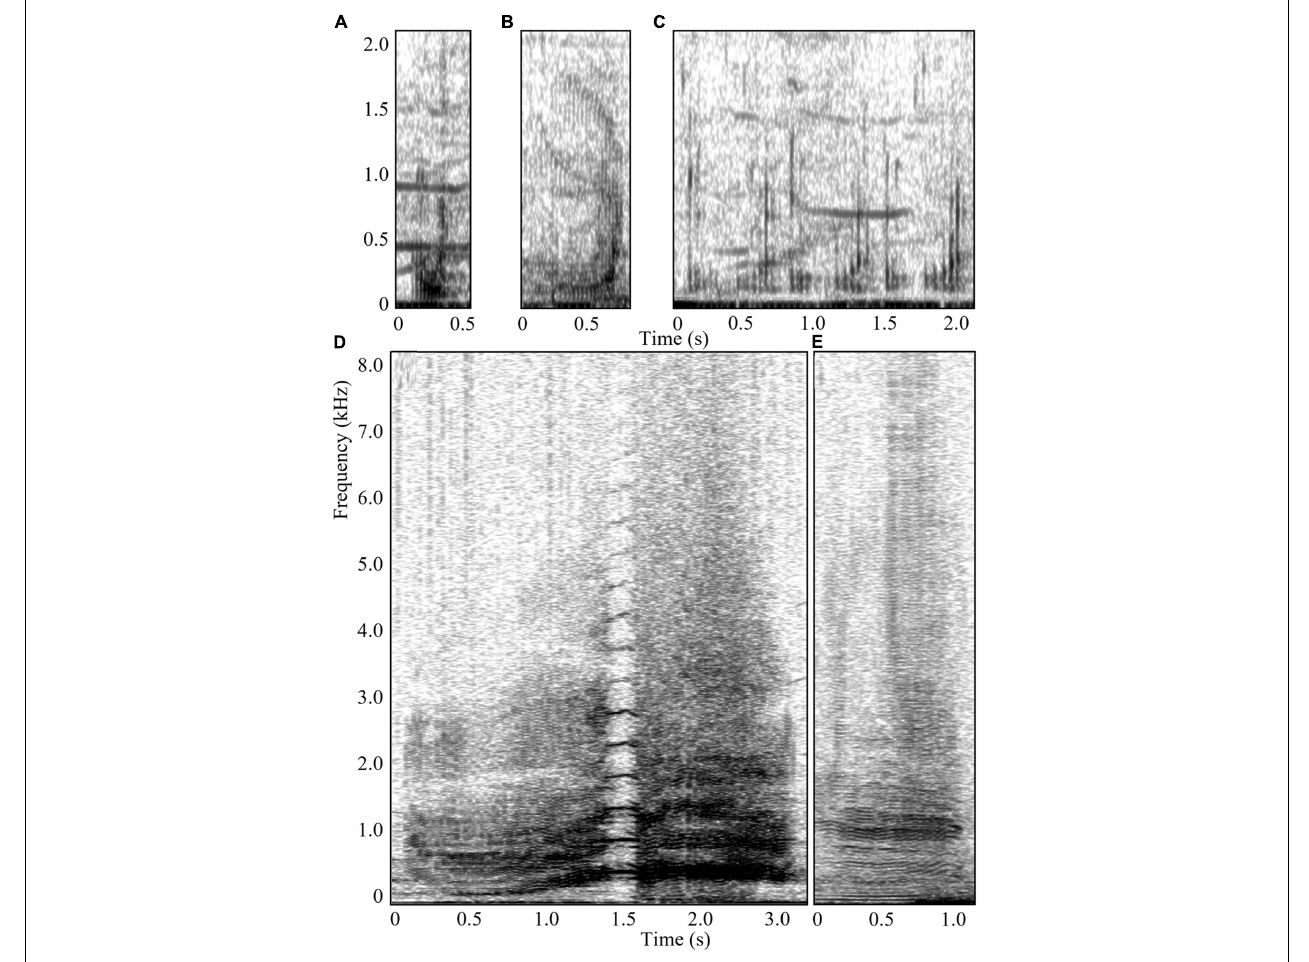
FIGURE 2 | Spectrograms (Hann window, Fast Fourier Transform 4096 samples, overlap 90%) of the relatively low frequency call types detected in competitive groups during this study: (A) “thwop,” (B) “whup,” (C) a series of “paired croaks,” (D) a graded call, and (E) a low frequency “song unit social call.” Sound clips can be found in Supplementary Material